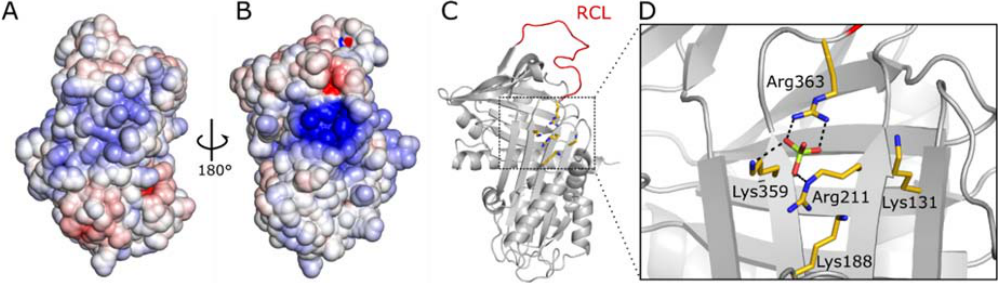
Figure 5. Heparin and phosphate ion binding site of vaspin. ( A , B ) Electrostatic potential at the molecular surface of vaspin (PDB 4IF8) [7] as viewed from the opposite sides. A large area of strong positive potential is visible in the orientation depicted in ( B ). Potential values < − 8 kT/e are colored in red and values > +8 kT/e in blue. The electrostatic potential was generated with the program APBS [35]. The protein orientation in ( B ) is the same as that of ( C ), showing the protein fold and the basic residues generating the strong positive electrostatic potential. The reactive center loop (RCL, red) is flexible in the crystal structure and modeled here for orientation. Five basic resides are present in the area of the distinct positive potential ( C ) and a sulfate ion is coordinated by three side chains ( D ).